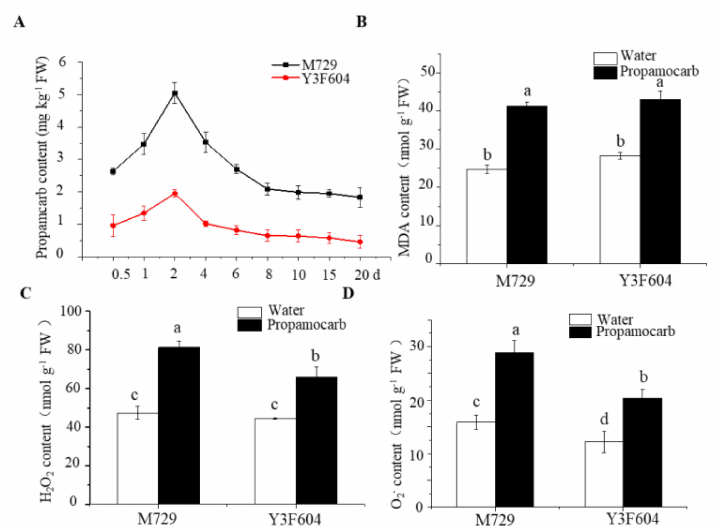
Figure 1. Propamocarb residues and phytotoxicity in the leaves of M729 and Y3F604 cucumber varieties. ( A ) Propamocarb residues at 0.5, 1, 2, 4, 6, 8, 10, 15, and 20 d; ( B ) MDA content at 2 d; ( C ) H 2 O 2 content at 2 d; and ( D ) O 2 − content at 2 d after application of 2 mM propamocarb. Data are the means of three replicates with SEs, and different letters indicate significant differences ( p <